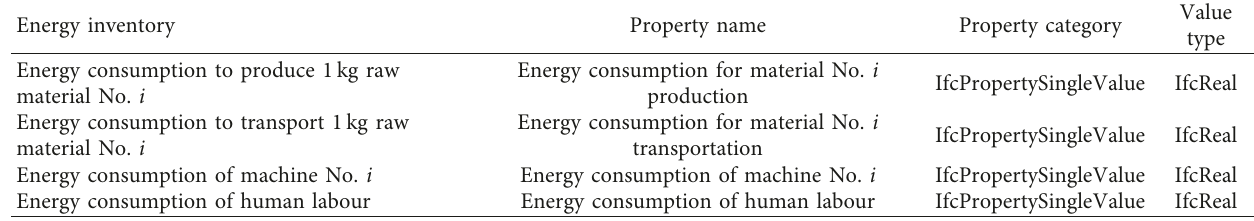
Table 5: Definitions of properties of prefabricated column production.